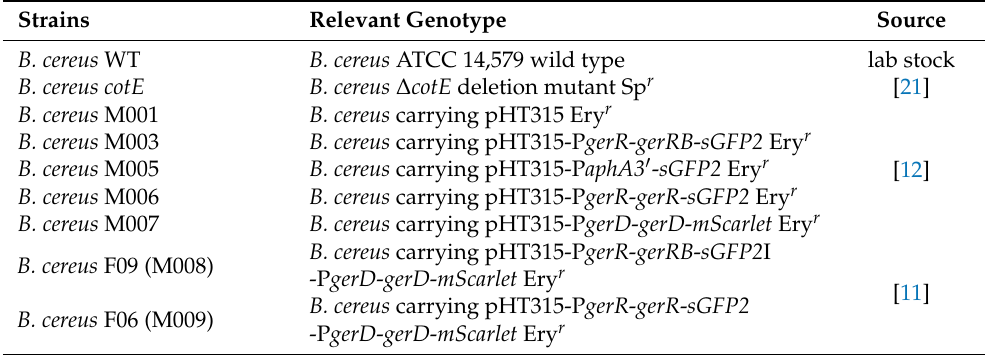
Table 1. Strains used in this study.